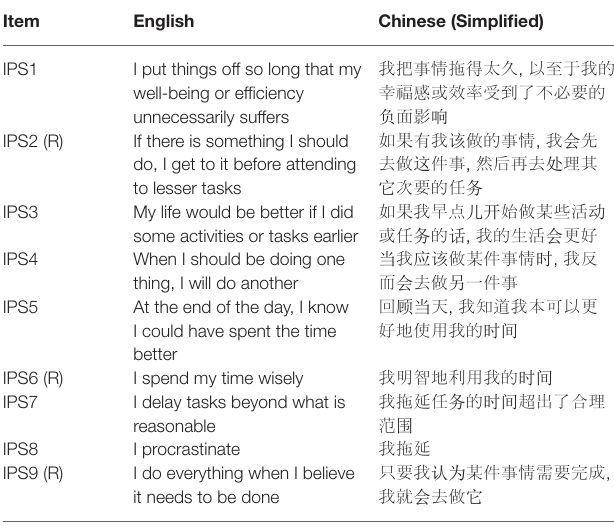
TABLE 1 | Irrational procrastination scale (IPS) items in English and